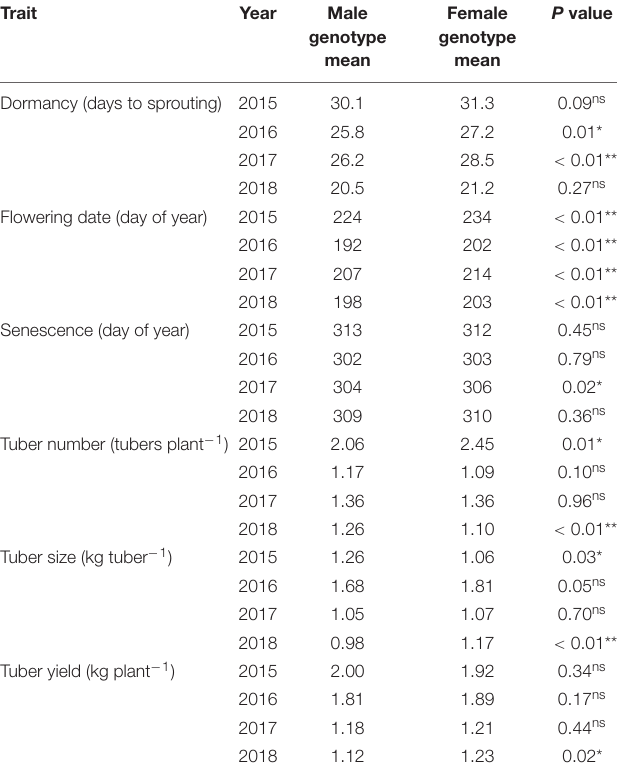
TABLE 2 | Trait comparison between the sex genotypes in the plants with male phenotype.